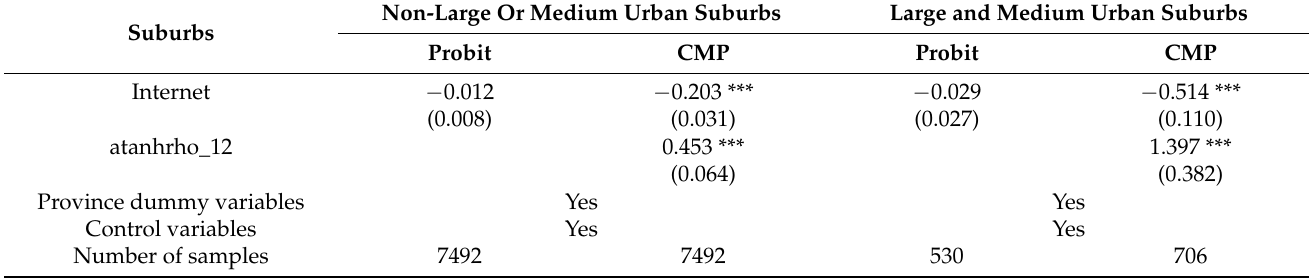
Table 5. Suburban regression results.